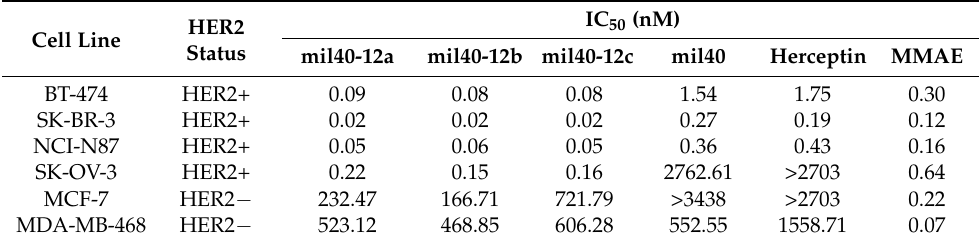
Table 1. Cytotoxicity of ADCs, antibodies and MMAE in cancer cell lines in vitro.